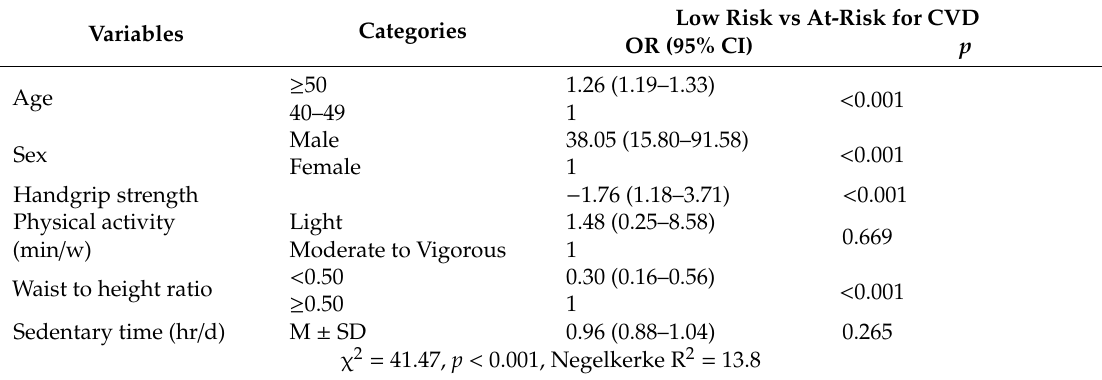
Table 3. Factors a ff ecting cardiovascular risk according to